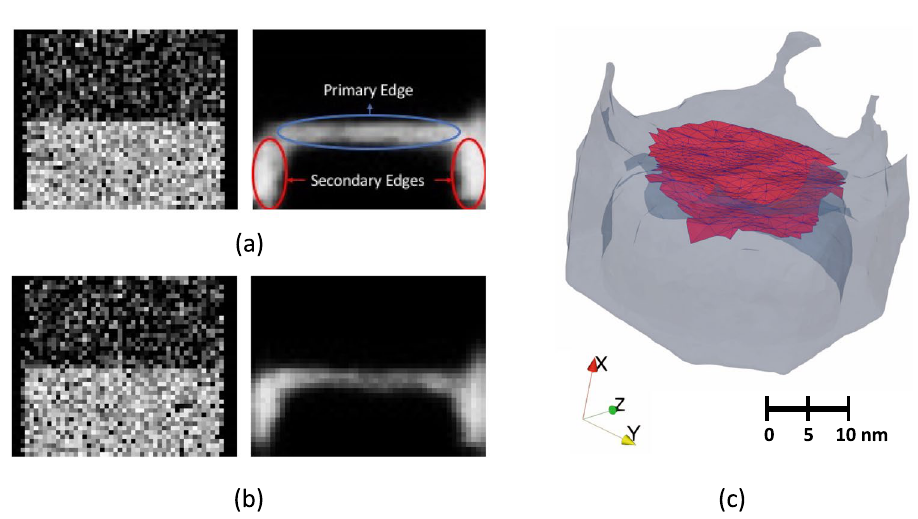
Figure 2. Two- and three-dimensional edge detection map in synthetic Co-Al-W alloy generated by using IVAS. ( a ) Concentration space (left) and edge detection map (right) of a slice along the Y-direction. The desired primary edge separating the two layers as well as the secondary edges is highlighted, ( b ) Concentration space (left) and edge detection map (right) of a slice along the Z-direction, ( c ) edge surfaces extracted after merging the edges in Y- and Z